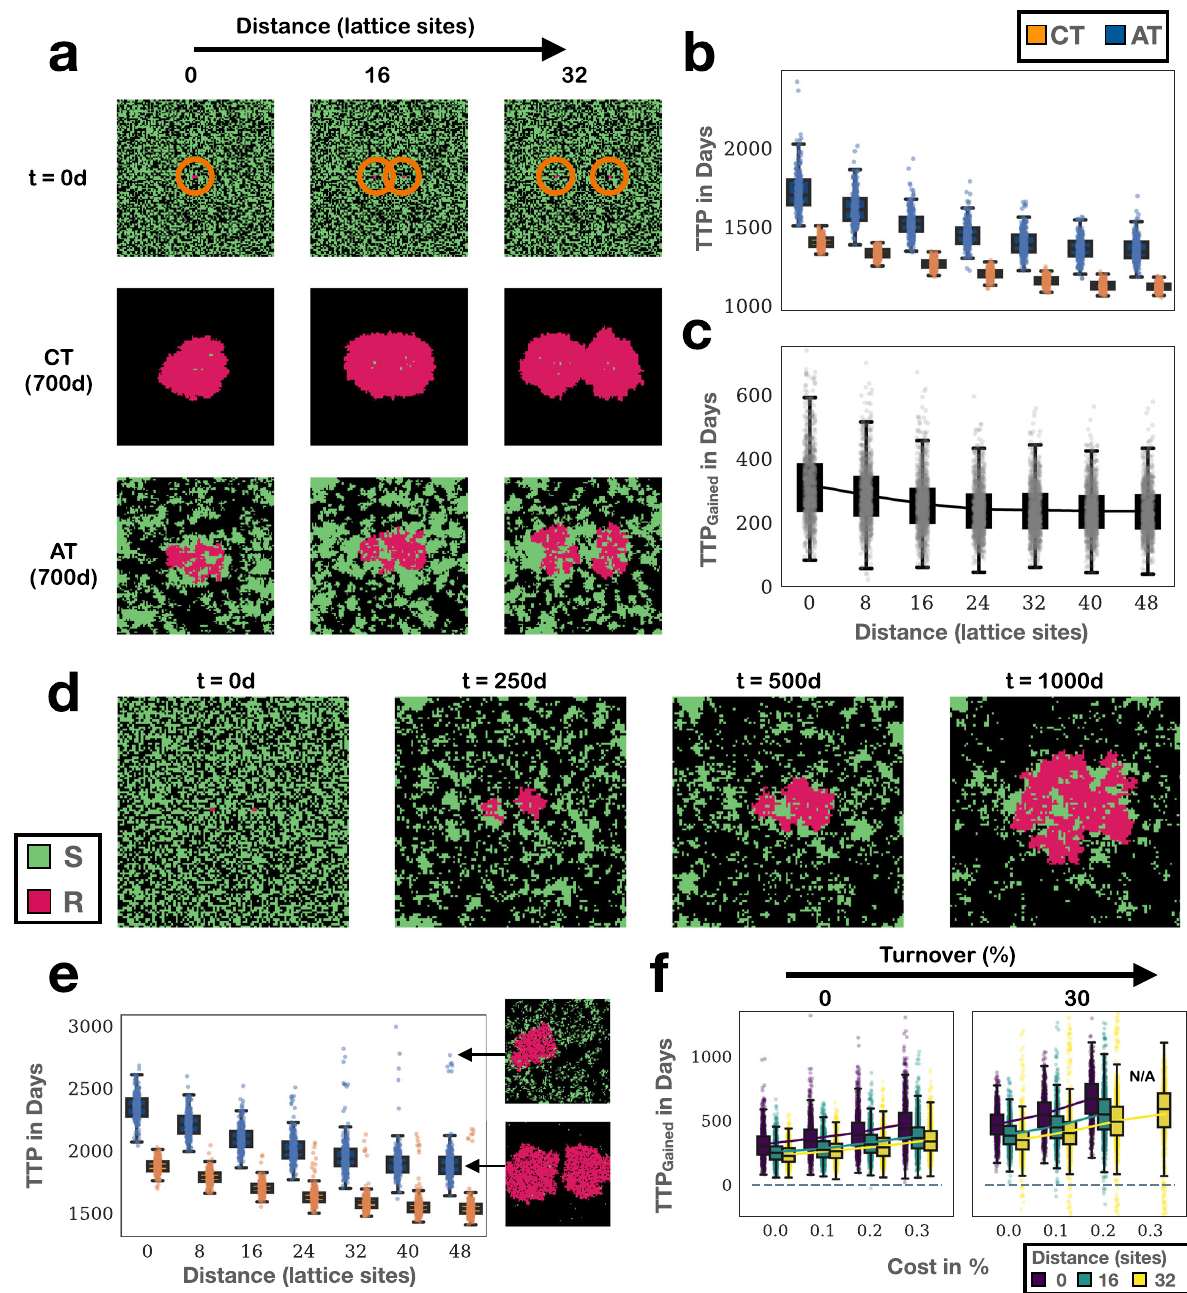
Fig. 4 The impact of the initial spatial distribution of resistance on adaptive therapy highlights the role of intra-speci fi c competition. AT: adaptive therapy, CT: continuous therapy, TTP: time to progression. a We seeded eight resistant cells either as a cluster in the centre, or as two nests at varying distances apart (marked with orange rings in the top row). Shown are representative snapshots from simulations for three different initial levels of separation (( n 0 , c R , d T ) = (50%, 0%, 0%)). Observe how there is more scope for interaction between sensitive and resistant cells as nests are seeded further apart, suggesting that these should be better controllable with adaptive therapy. b However, TTP of continuous and adaptive therapy decreases as the separation between the nests increases ( n = 1000 replicates per conditions; parameters as in a ). c Similarly, the bene fi t of adaptive therapy decreases the greater the separation between the nests (TTP Gained = TTP AT – TTP CT , where TTP AT and TTP CT is the time to progression under adaptive and continuous therapy, respectively; n = 1000 replicates per conditions; parameters as in a ). This indicates that not only intra- but also inter-speci fi c competition are important in adaptive therapy. d Representative snapshot from a simulation in a in which the nests are initially 16 lattice sites apart, which illustrates one reason why control of multiple nests is more challenging. While the left nest can initially be controlled, the right nest escapes and, in turn, triggers release of the left nest. e TTP as a function of initial separation distance in the presence of turnover ( d T = 30%; n = 1000 replicates per condition). Turnover can cause extinction of one of the two nests, which greatly increases TTP (see insets, which show simulation snapshots at t = 1500d). f Effect of the initial spatial distribution of resistance on the relationship between cost, turnover and gain of adaptive therapy ( n = 1000 replicates per condition). “ N/A ” indicates that data were not shown because less than 1/4 of simulations had completed within 10 years (cured or progressed). Throughout the fi gure, the box, centre line, and whiskers in box plots denote the inter-quartile range, median, and 1.5x inter-quartile range,